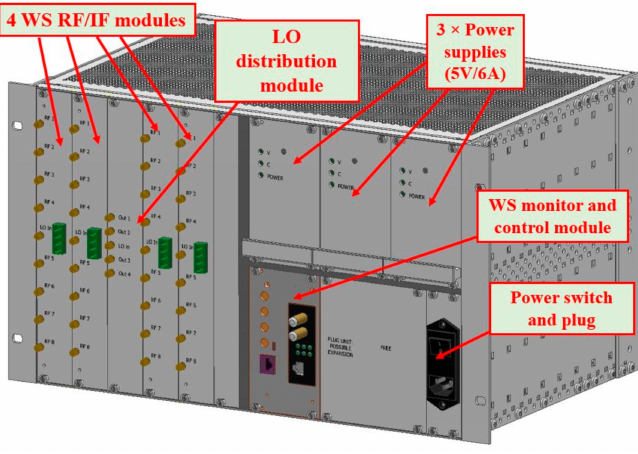
Figure 3. Design of PHAROS2 Warm Section multi-channel receiver.